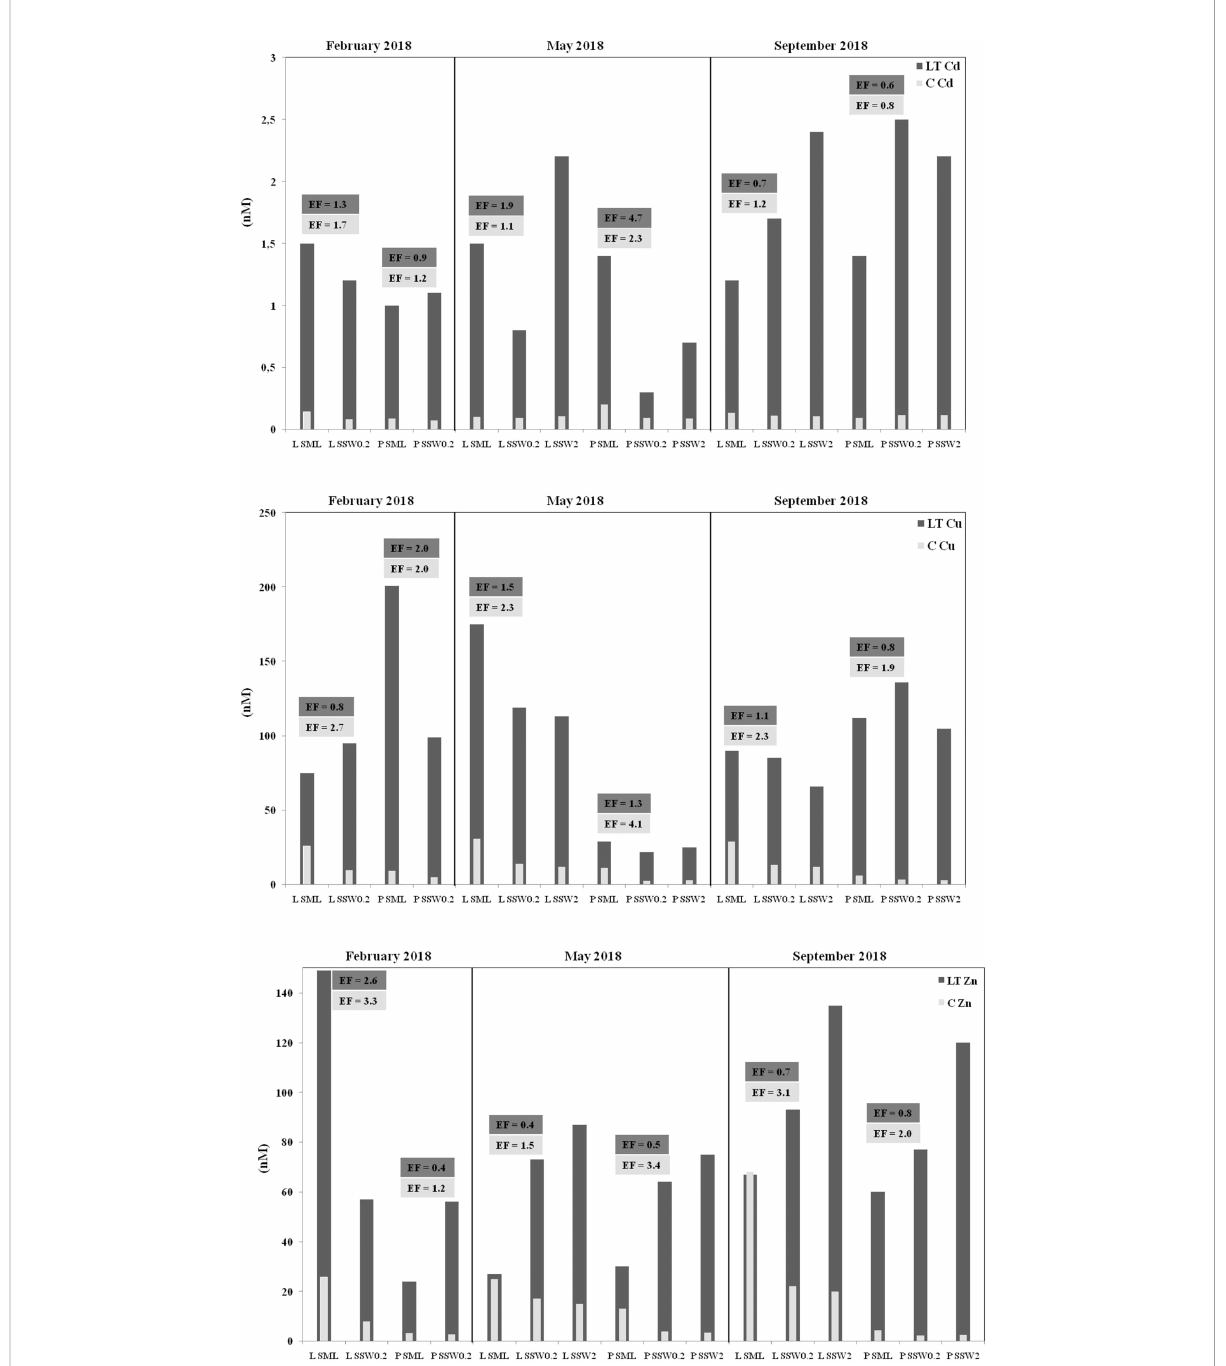
FIGURE 2 Metal-binding ligands ( L Cd , L Cu , L Zn ), dissolved metal concentrations (C Cd , C Cu , C Zn ), and their enrichment factors (EFs) in surface microlayer (SML) and sub-surface (SSW 0.2 , SSW 2 ) marine coastal waters of Loutropyrgos (L) and Pahi of Megara (P) sampling